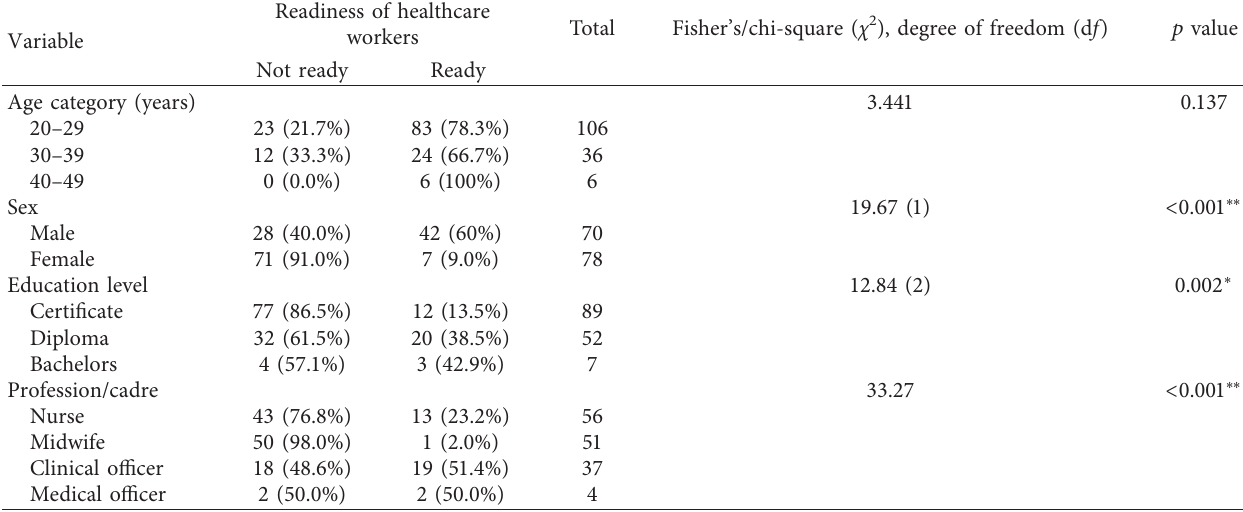
Table 6: Bivariate analysis between readiness among healthcare workers and sociodemographic characteristics.